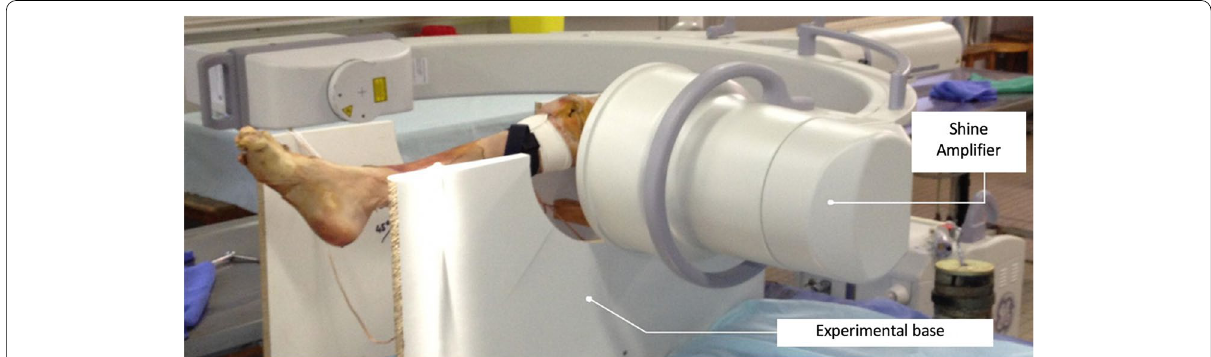
Fig. 1 Experimental set‑up and lateral radiographic image of the knee in extension with posterior